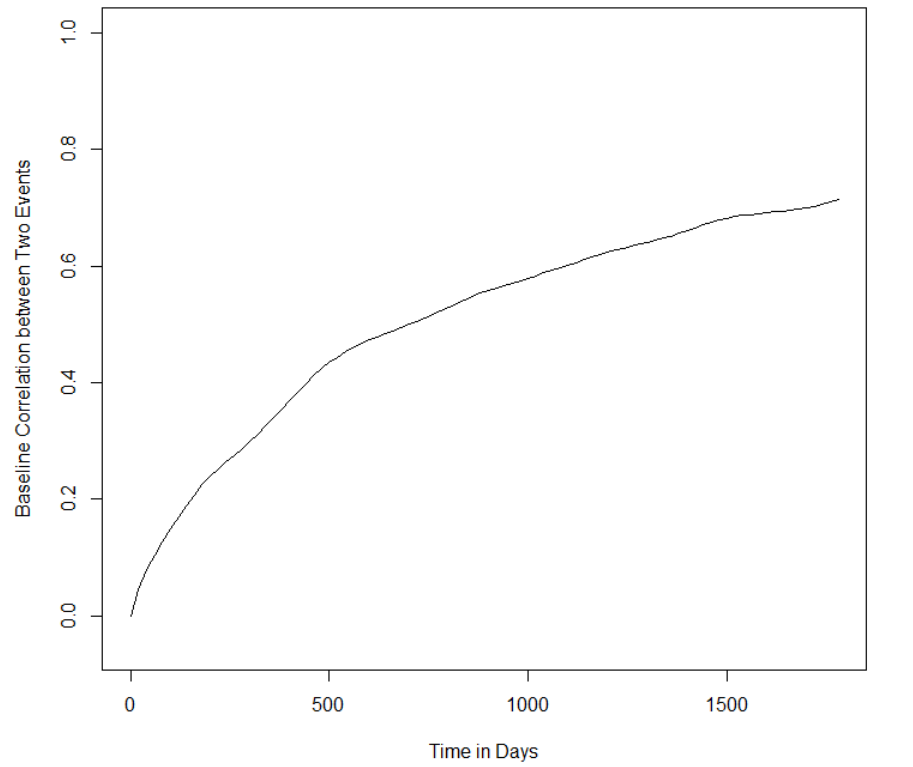
Figure A5. Estimated baseline correlation between basal cell carcinoma and squamous cell carcinoma across